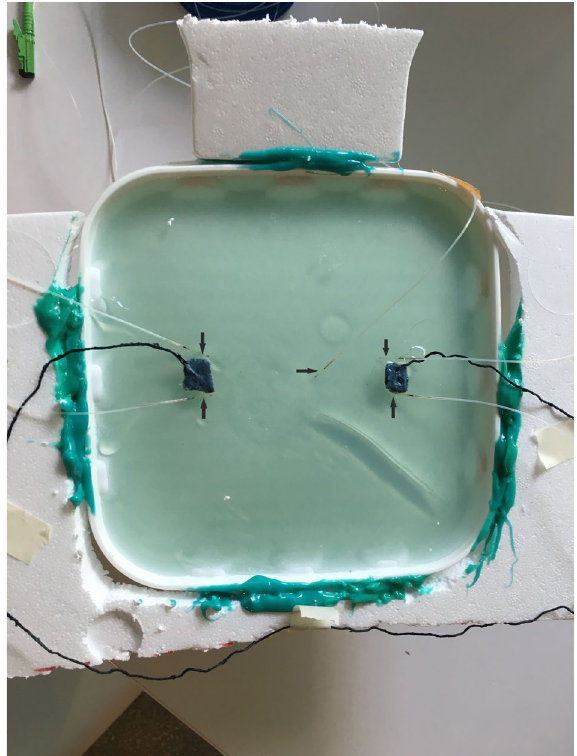
Figure 1. Head phantom for MRI with PEDOT polymer electrode and conductive textile wire. Top view on the agarose filled plastic bottle. The lid is also filled with agarose and two small pieces of gauze are embedded in the agarose as anchor points for the electrode. The polymer electrode and the cable are attached to these two points (black). The cable connecting the two electrodes is fixed as a loop on a styrofoam frame to force possible heating effects. Next to the polymer electrode, 2 temperature sensors are embedded in the upper layer of the agarose (white fiber strands). Another temperature sensor is placed as a reference in the middle of the lid, between the electrodes. The embedded tips of the fibre optic temperature sensors are marked with black